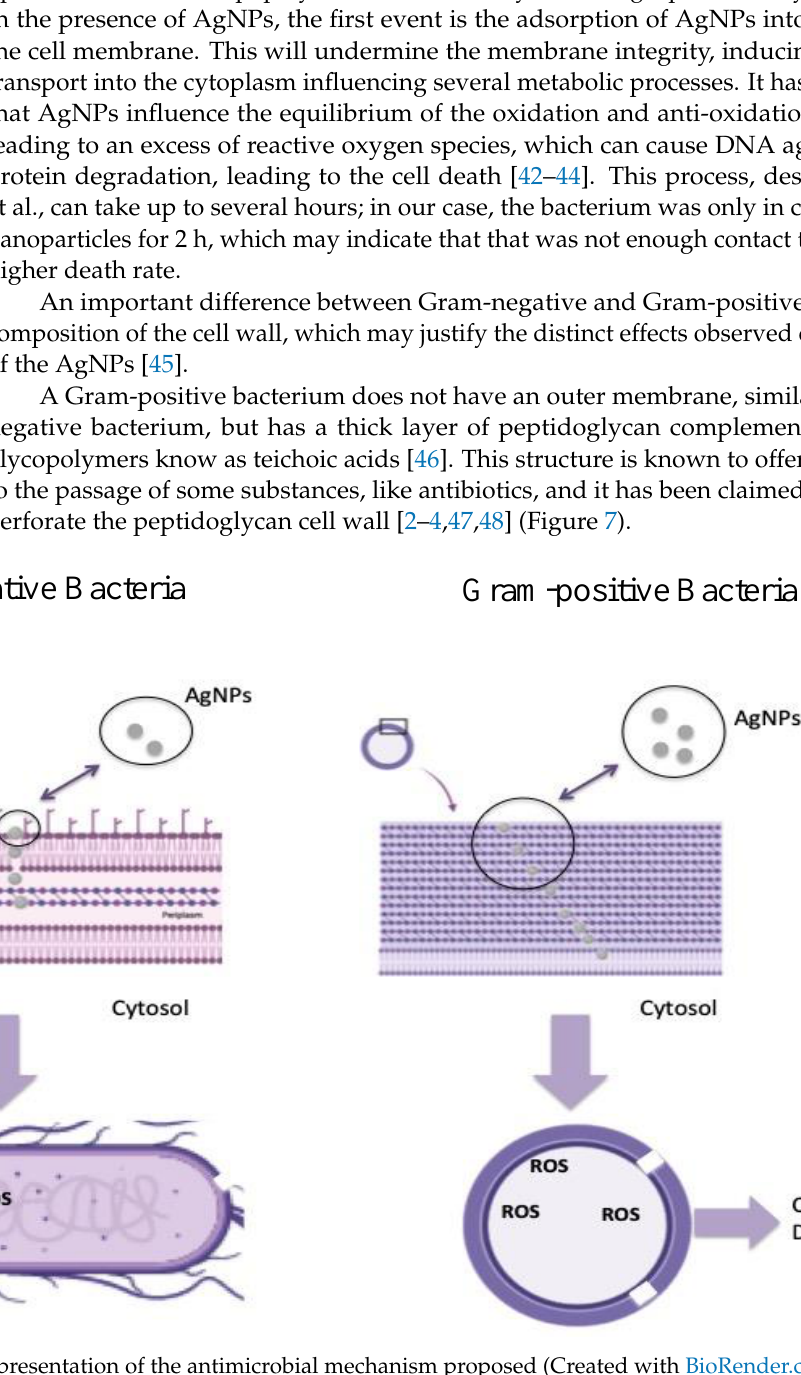
Figure 7. Schematic representation of the antimicrobial mechanism proposed (Created with BioRender.com).